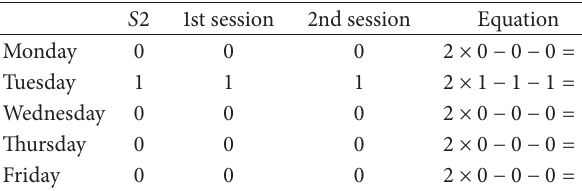
Table 6: 𝑆2 : variable equals